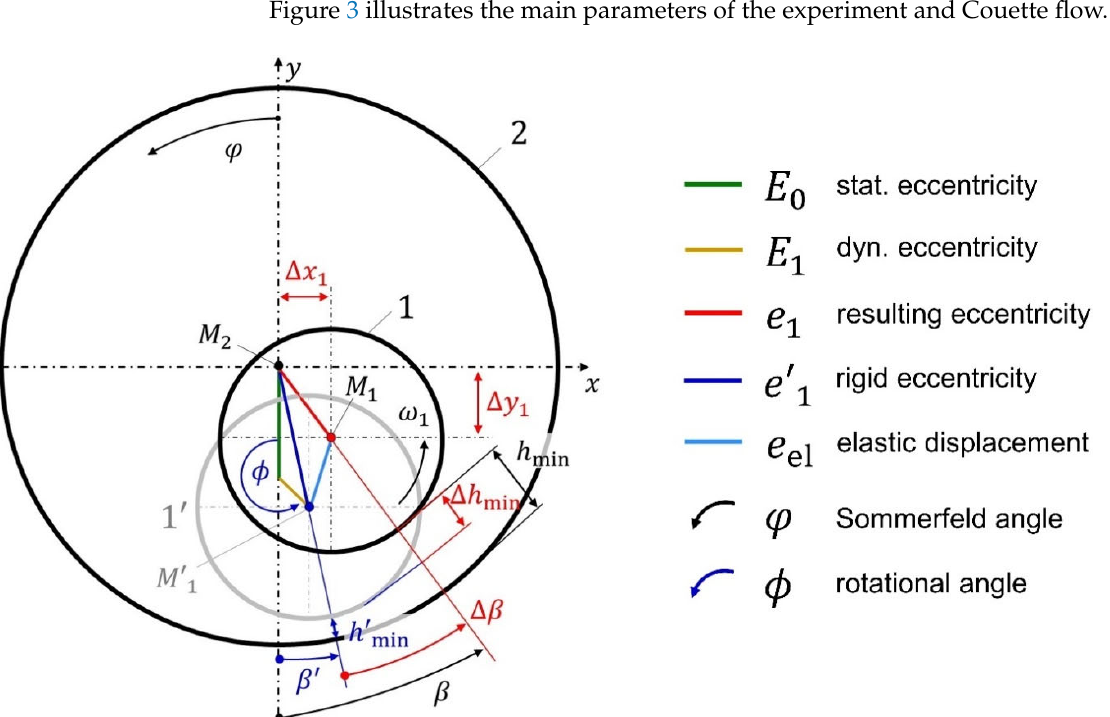
Figure 2. Optical access into the fluid film; viewing area located downstream of minimum film thickness.